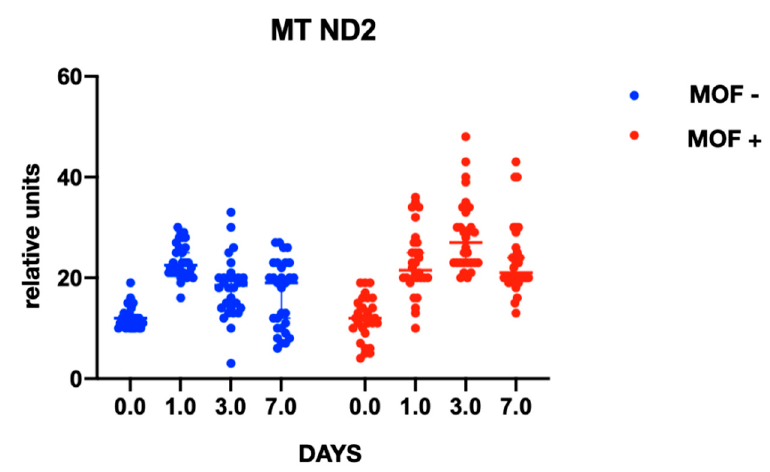
Figure 5. NADH2 gene expression.